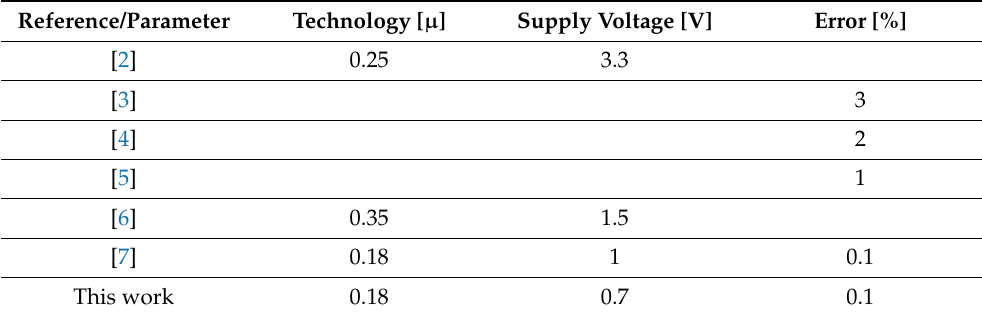
Table 2. Comparison between the proposed Gaussian circuit and previous reported